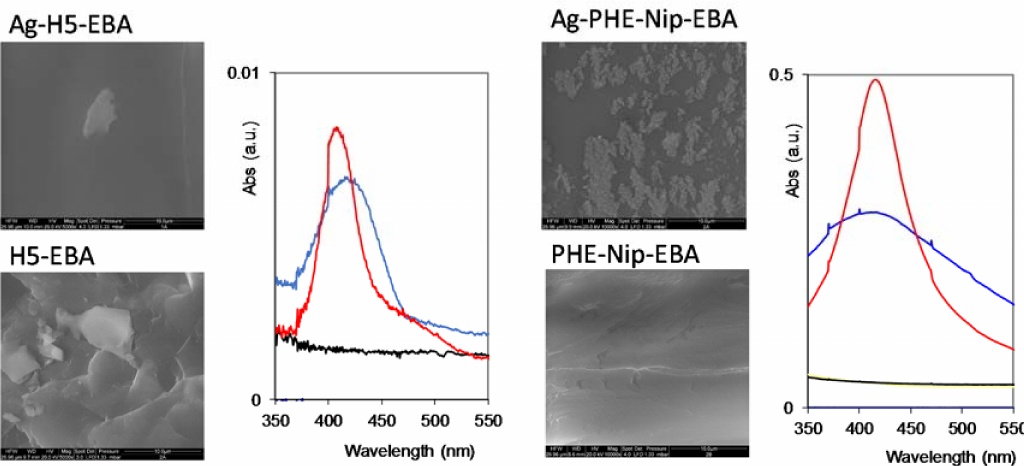
Figure 5. SEM images (scale bar 10 µ m) and UV-visible spectroscopy of hydrogels H5-EBA and PHE-Nip-EBA with (above) and without (below) silver nanoparticles. Hydrogels complexed with Ag + (black line), with silver nanoparticles (blue line), and after 24–48 h (red